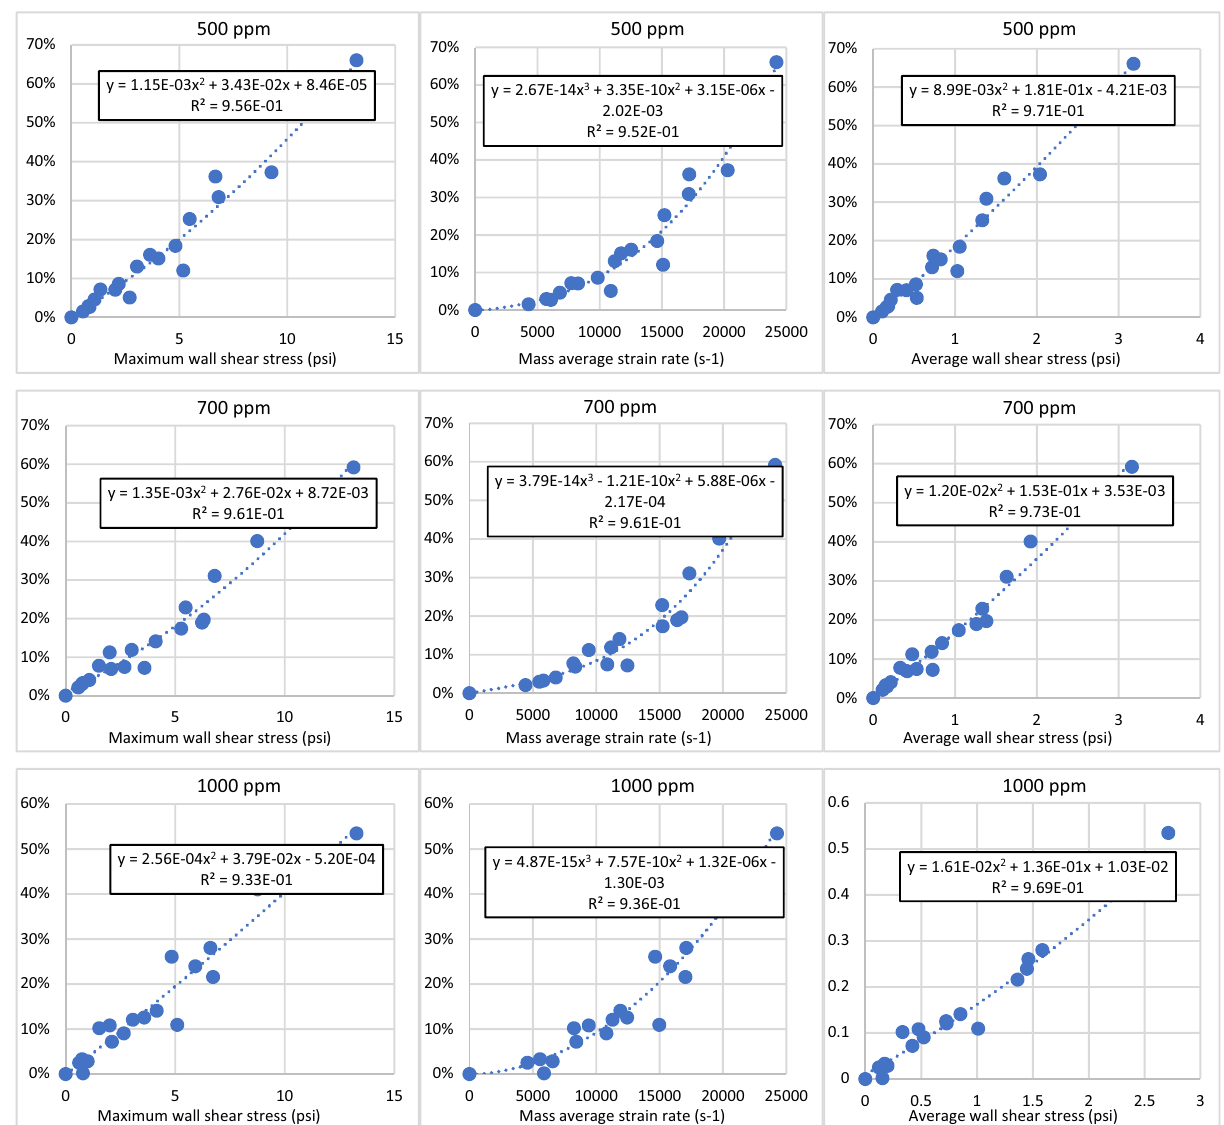
Fig. 11 Relation between the percentage of degradation and the strain rate/wall shear stress. In every graph, the y axis (vertical) corresponds to the percentage of degradation. Variable x in equations corresponds to the horizontal axis